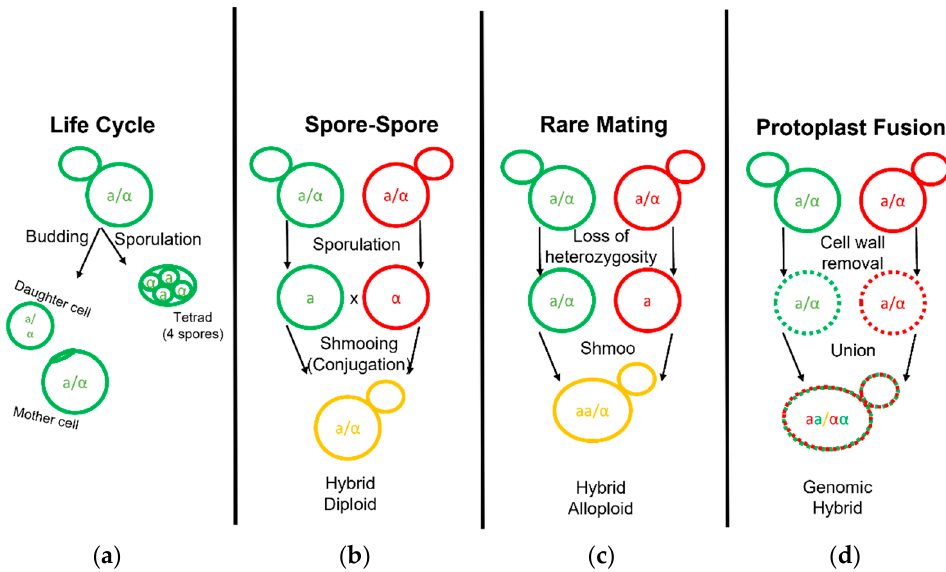
Figure 2. Life and Mating of Saccharomyces Yeast. Diagram pertaining to the clonal growth typical of yeast fermentation cultures and the various known techniques employed to generate yeast hybrids . ( a ) Diploid yeast cells may bud and grow clonally to form a mother and daughter cell or undergo sporulation to form a tetrad. ( b ) Yeast hybridization may form by direct spore to spore mating. ( c ) Yeast hybridization may form by rare mating events in which one or both diploid parent cells gain competency by becoming hemizygous or MATa/MATa and MAT α /MAT α diploids. ( d ) Yeast hybridization may also form by fusion of two separate yeast cell protoplasts with their cell wall removed.